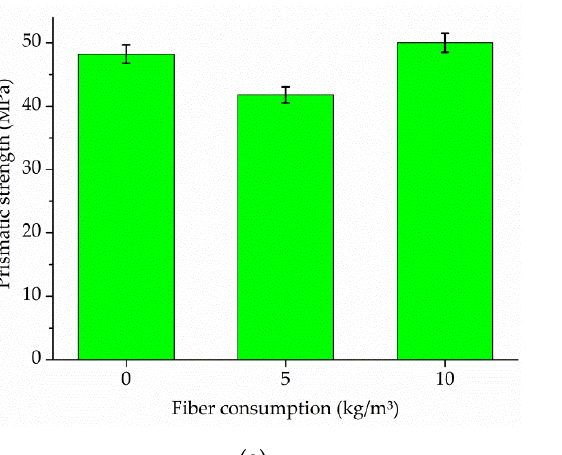
Figure 15. Load–displacement curves of cut faces of concrete with 5 kg/m 3 of fiber content.